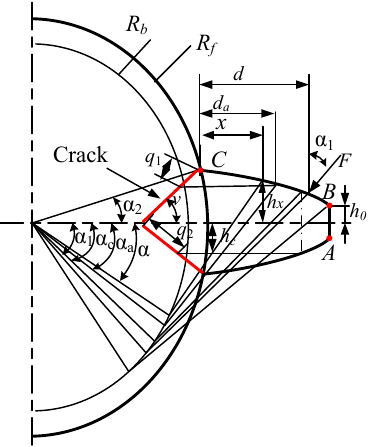
Figure 8. Stress diagram of Cracked Gear when the number of teeth is greater than 42.